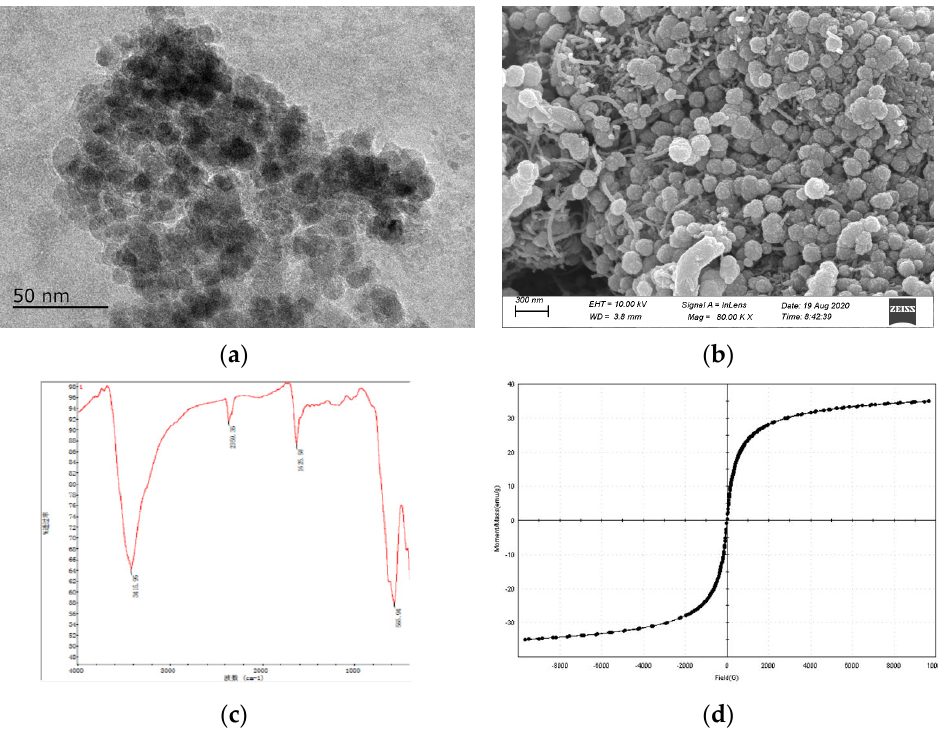
Figure 3. SEM image ( a ), TEM image ( b ), FT-IR spectrum ( c ) and magnetization curve ( d ) of Fe 3 O 4 /NH 2 -MWCNTs.